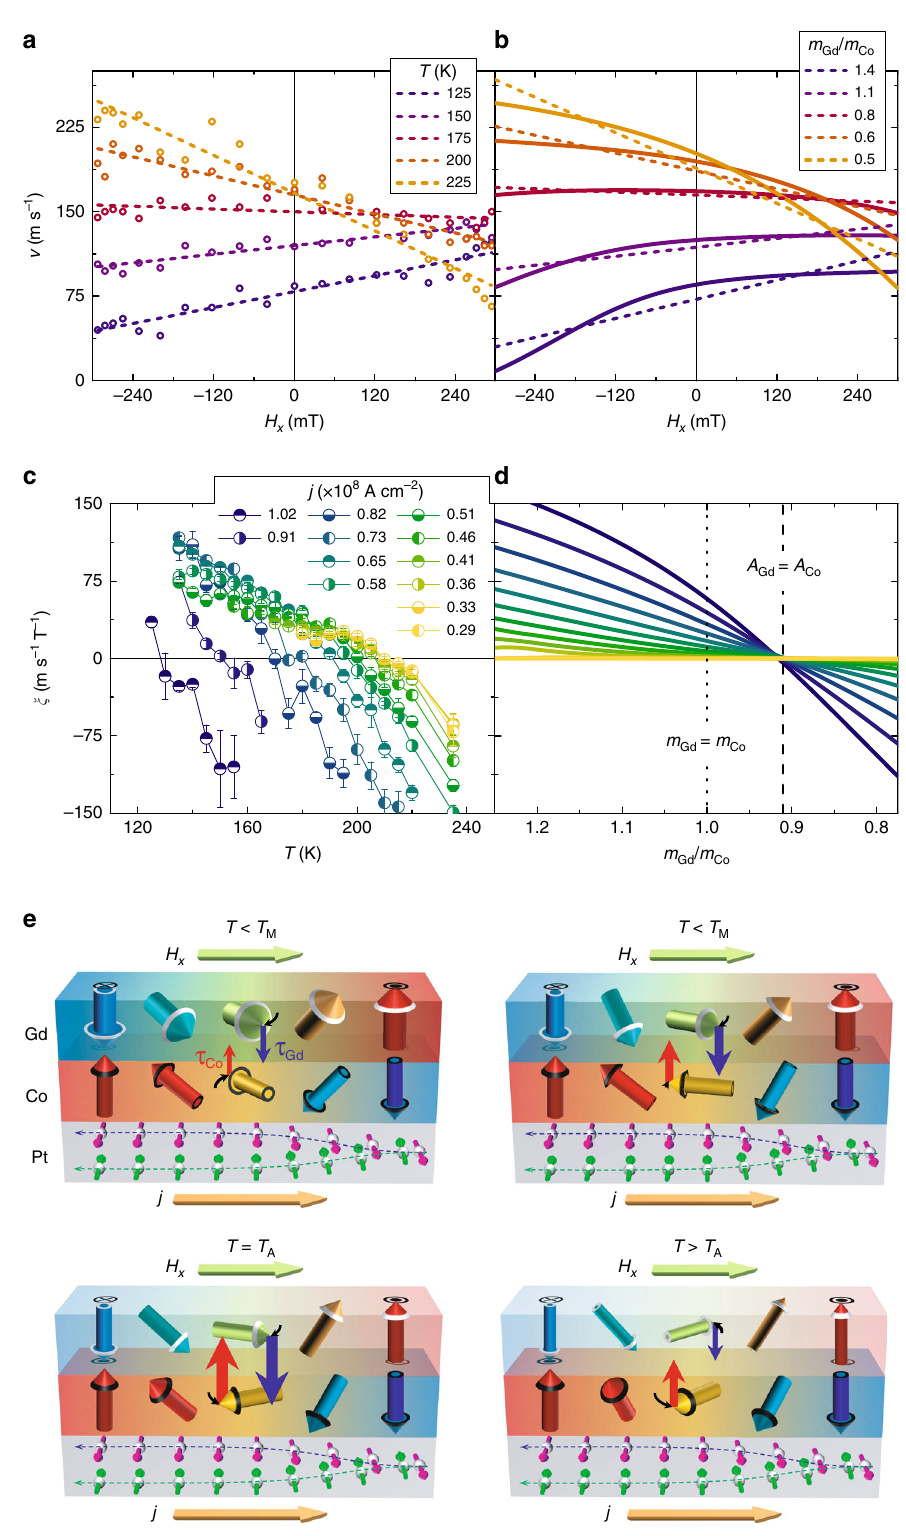
Fig. 2 Field-dependent CIDWM at various temperatures near T M and T A . a Experimental results of the dependence of DW velocity on H x for j = 0.82 × 10 8 A cm − 2 . Dashed lines are linear fi ts to the data which provide the slope ξ . b Analytical solutions of the dependence of DW velocity on H x . Dashed lines are linear fi ts to the analytical data which provide ξ . c Measured values of ξ versus T and ( d ) calculated values of ξ versus m Gd / m Co . The data correspond to 10 ns long voltage pulses. Error bars obtained from linear fi ts to data in a . e Sketch of DW structure in the presence of small H x and large j . Torque on both magnetic moments τ i is maximized at T A , where angle between magnetic moments